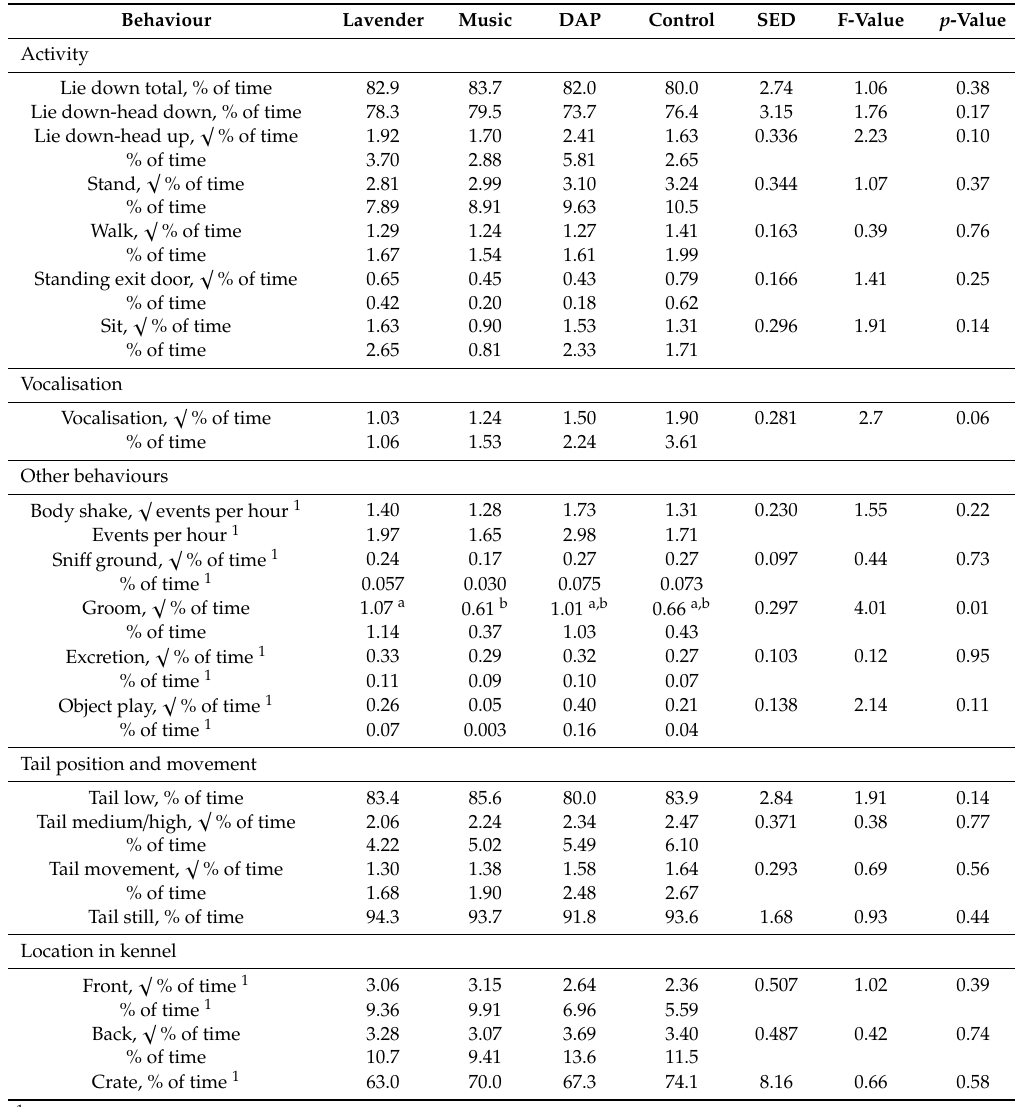
Table 4. The behaviour of dogs ( n = 60) exposed to Lavender, Music, DAP or a Control treatment during the Night